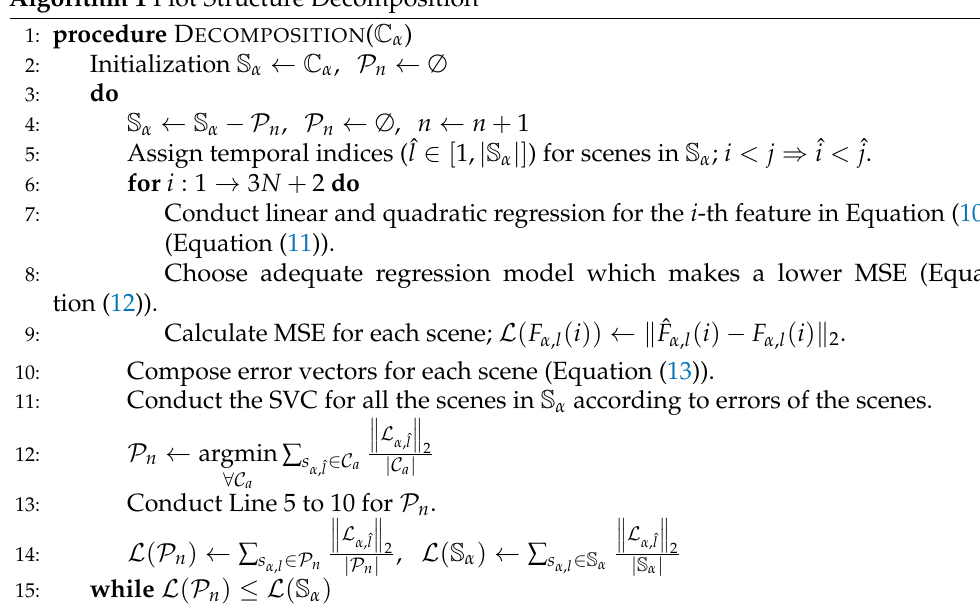
Algorithm 1 Plot Structure